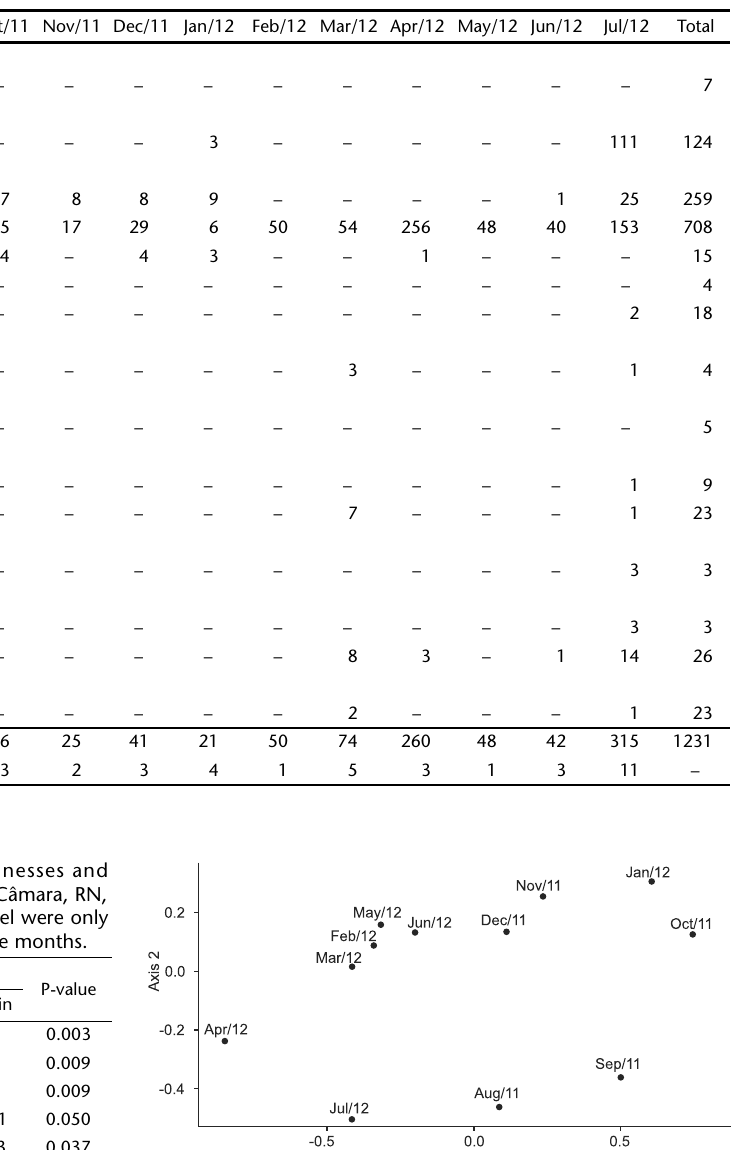
Table I. The diversity of Collembola captured between August/2011 and July/2012 at the Fazenda Cauaçu farm, João Câmara, Rio Grande do Norte, Brazil.